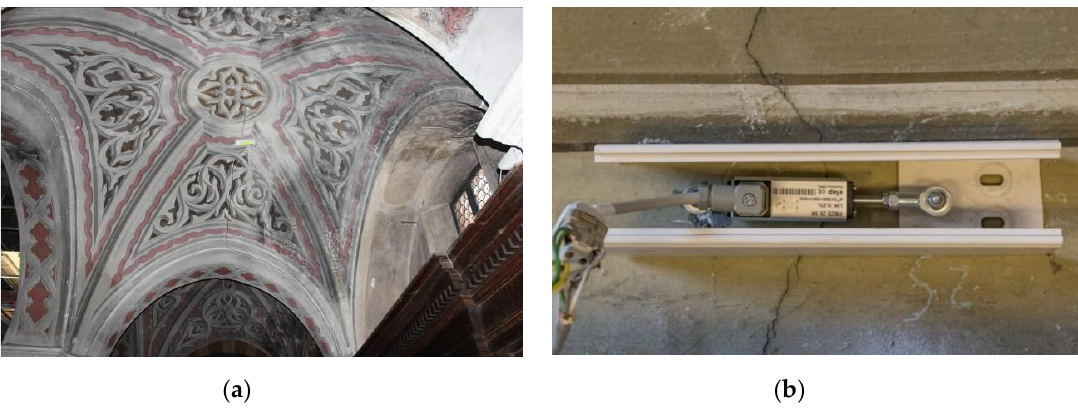
Figure 13. St. Bassiano: ( a ) monitoring of cracks in a masonry vault by means of ( b ) LVDT displacement transducers.